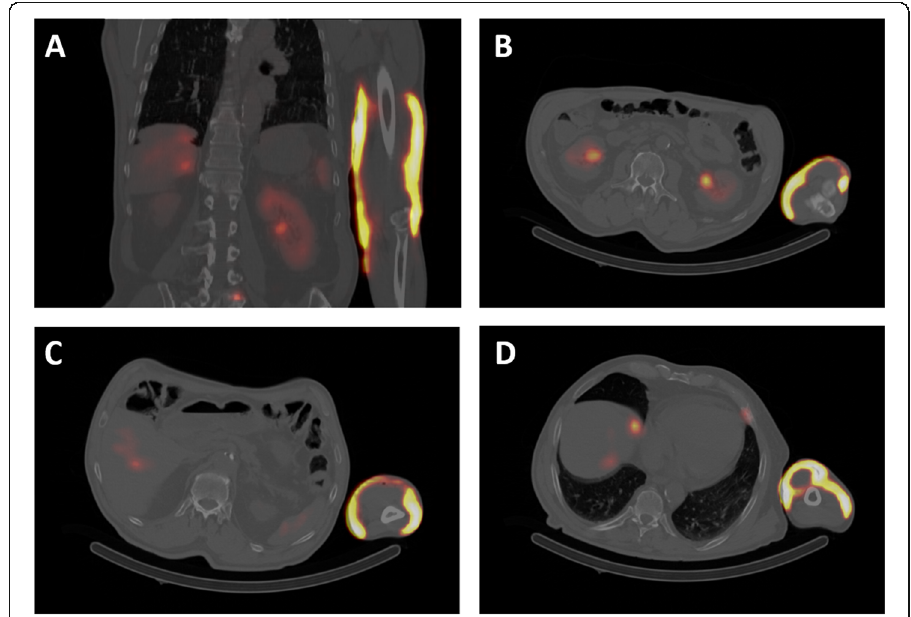
Fig. 6 Coronal slice ( a ) and axial slices ( b – d ) of T 5h SPECT/CT showing the subcutaneous distribution of the extravasation in the arm